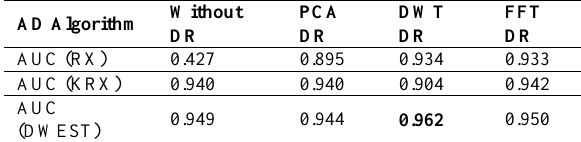
Figure 8. ROC curves of the DWEST AD family for Img- I. Table 2. AUC values of the AD methods applied to